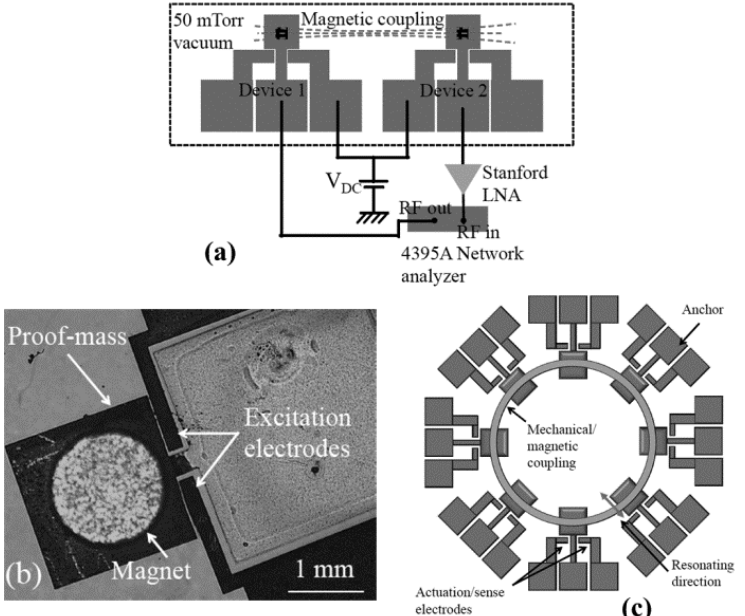
Figure 14. The magnetically coupled resonators: ( a ) Schematic of the experimental setup; ( b ) Optical microscope image; ( c ) A conceptual gyroscope. Reproduced with permission from [89]. Copyright © 2014, IEEE.